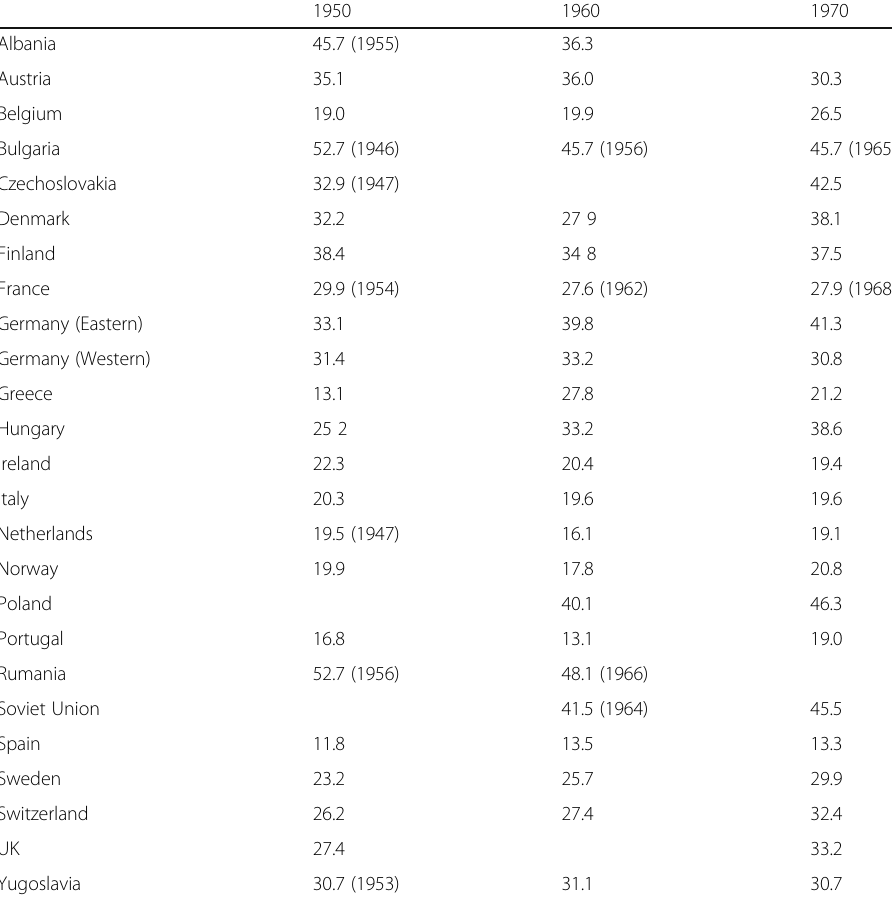
Table 4 Female activity rates, all ages, around 1950, 1960, and 1970 (exact year in brackets if considerably